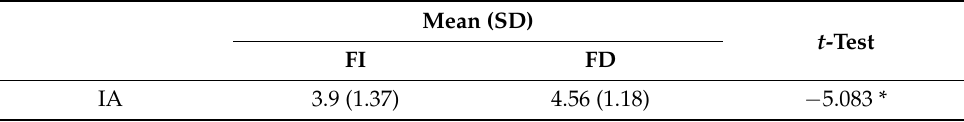
Table 6. Independent Sample t -test for different CS.